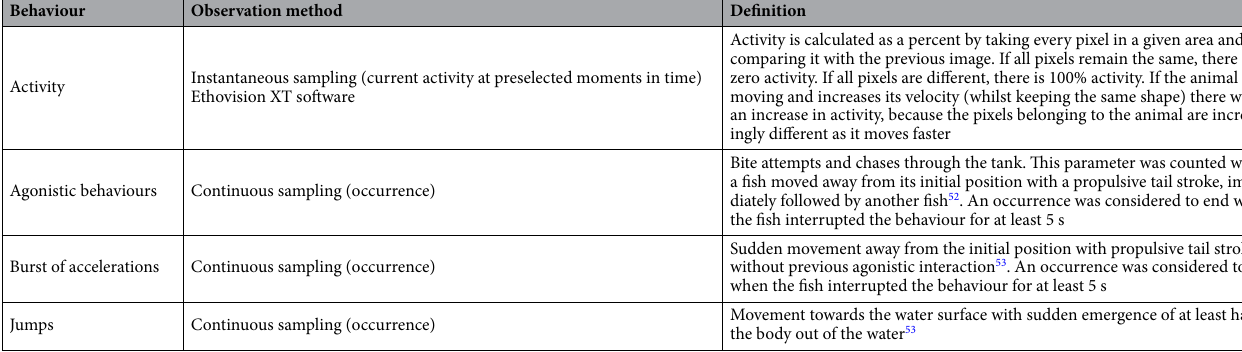
Table 1. Behavioural parameters used for observations during the 12 days of conditioning and feed omission